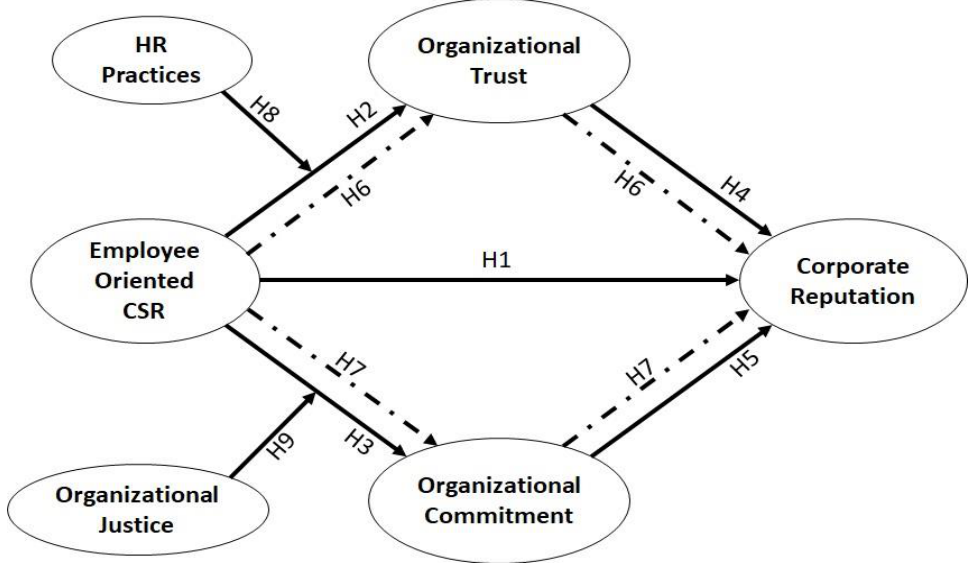
Figure 1: Theoretical